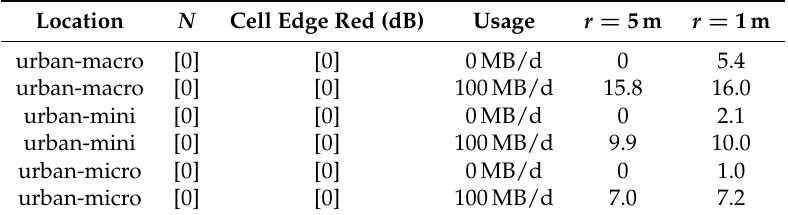
Table 3. Total dose change (in dB) as a function of bystander distance r . Shown are the 95th percentile values for non-users and light data users (100MByte/day) relative to the dose value of the non-user with a bystander 5m away, for each urban exposure